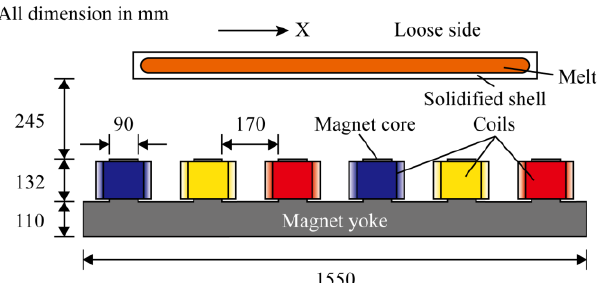
Figure 2. Schematic diagram of SEMS system in the top view. SEMS system was located at the fixed